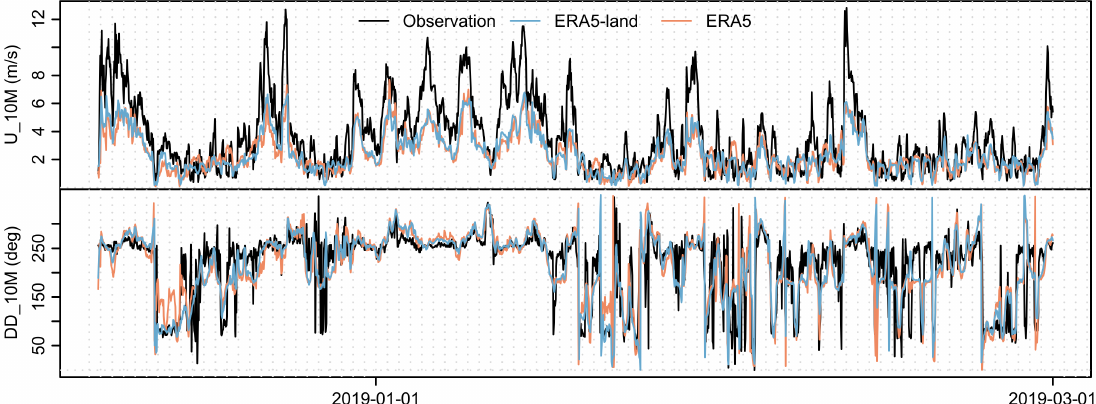
Figure 10. Observed wind speed and direction 10 m above ground at the Holzkirchen site compared to the ERA5 reanalysis for the period 7 December 2018 to 28 February